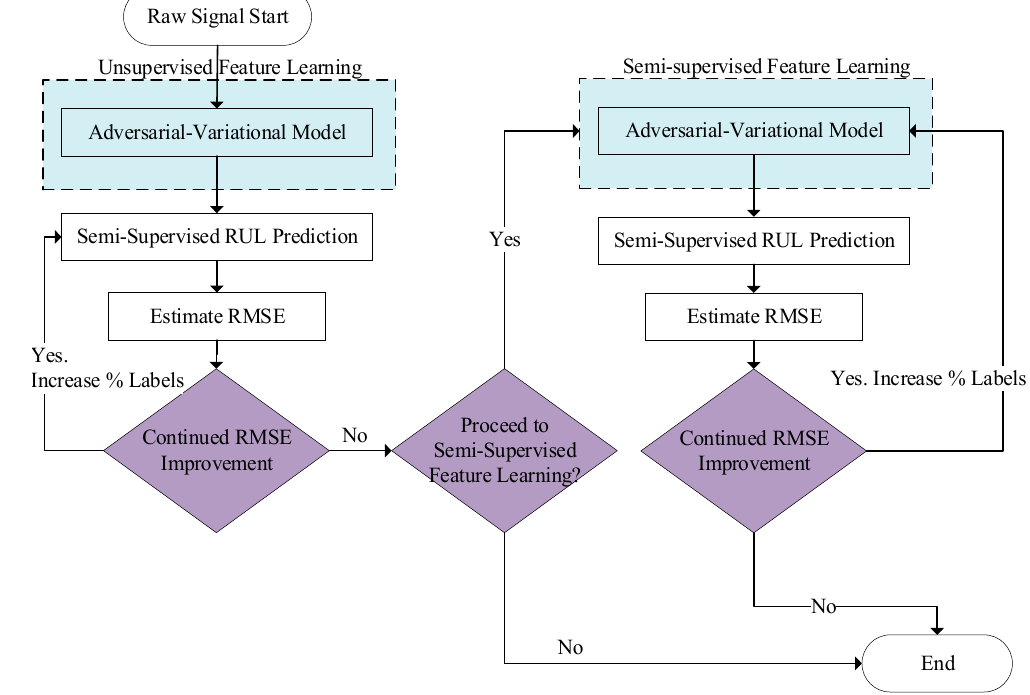
Figure 4. Proposed deep generative methodology for remaining useful life estimation.